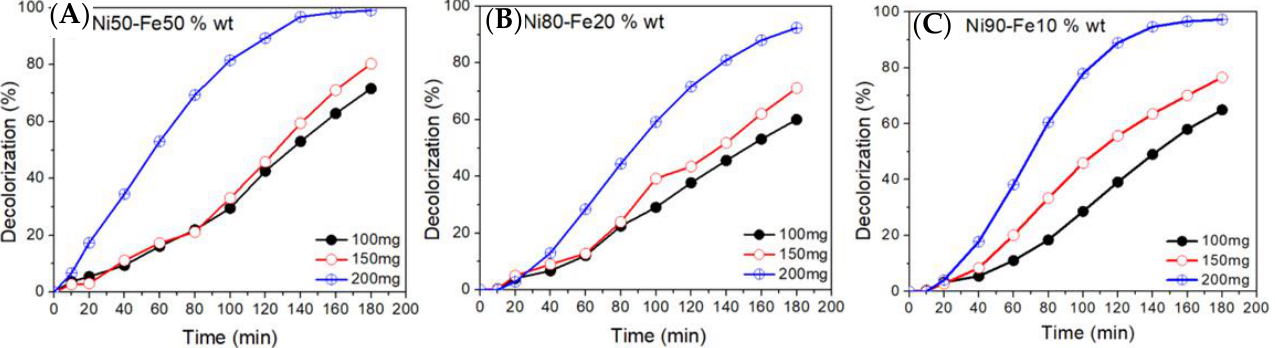
Figure 8. Percentage decolorization of RB5 at specific time intervals under different loads of Ni-Fe samples for ( A ) Ni50-Fe50wt%, ( B ) Ni80-Fe20wt%, and ( C ) Ni90-Fe10wt%.